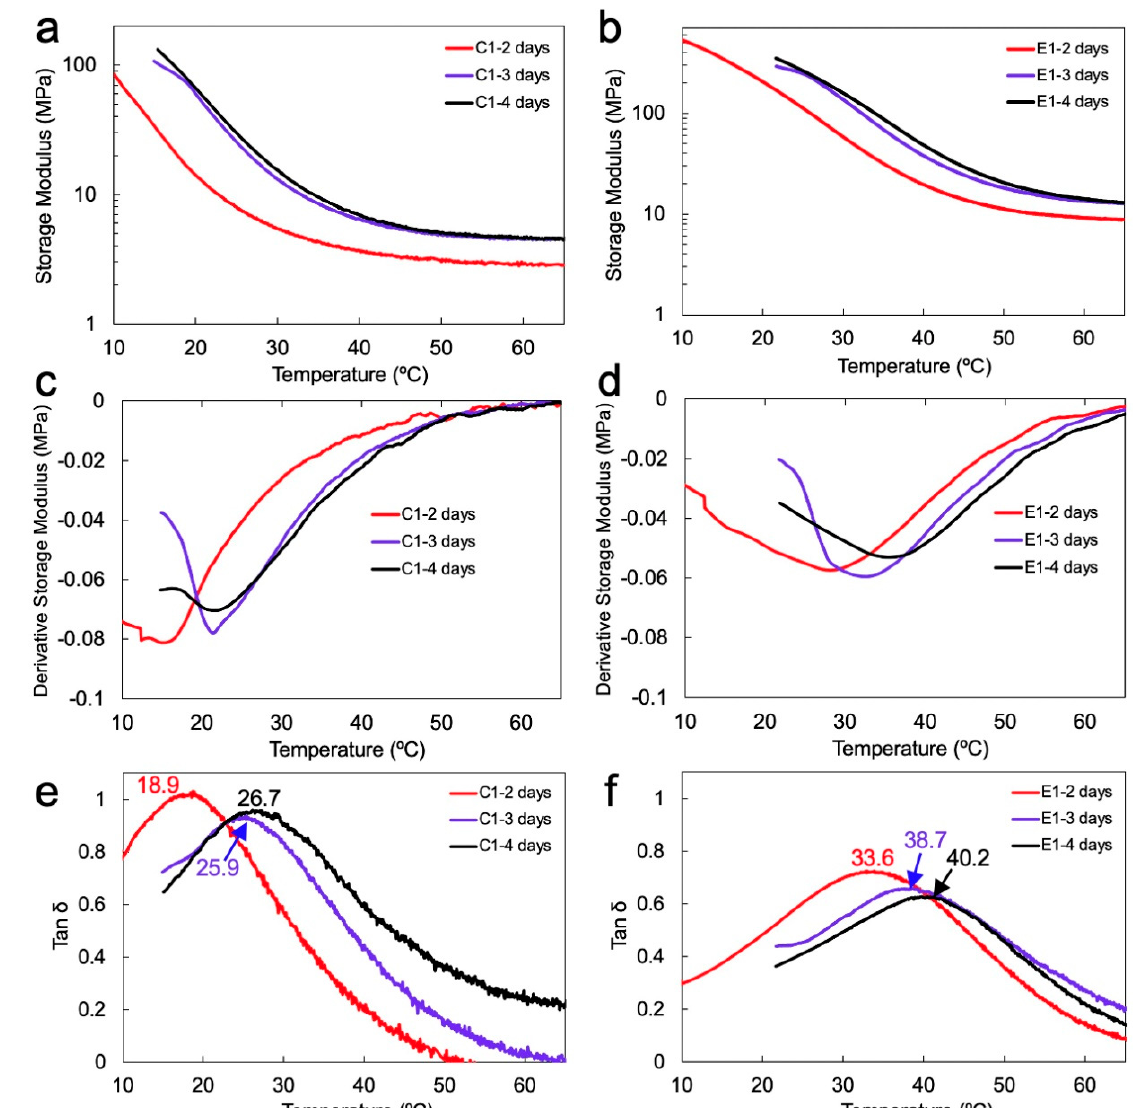
Figure 3. Representative plots of ( a , b ) storage modulus, ( c , d ) derivative storage modulus, and ( e , f ) tan δ as a function of temperature for water-saturated C1 and E1 copolymers in wet condition.